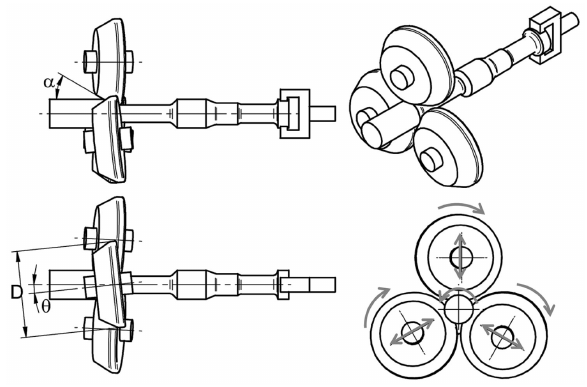
Figure 1: Schematic design of skew rolling by three tapered